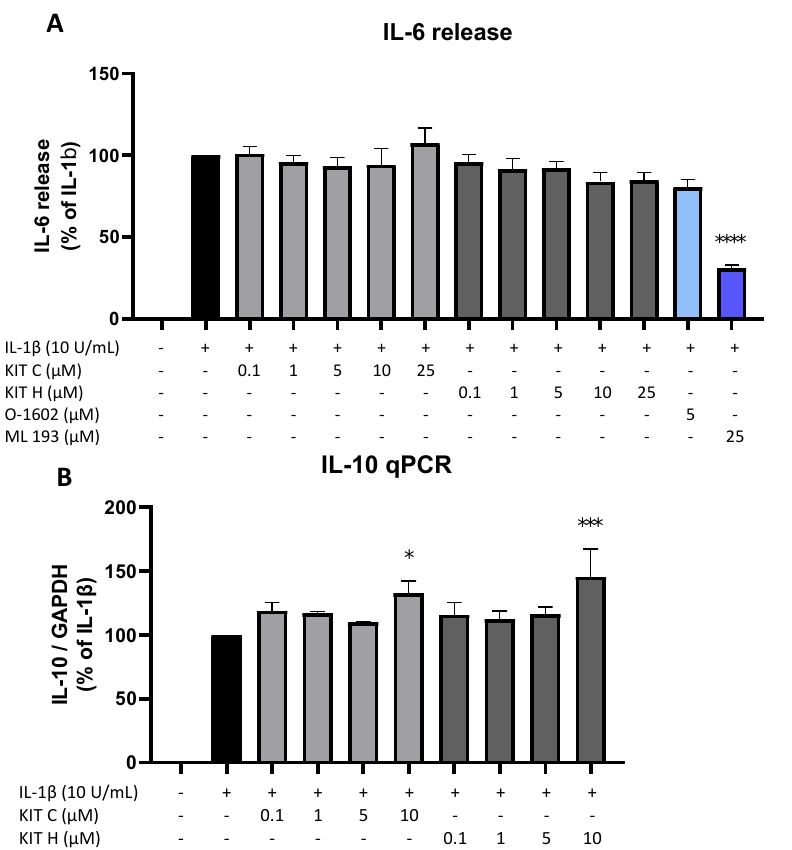
Figure 7. Effects of KIT C (light grey bars), KIT H (dark grey bars), O-1602 (light blue bar), and ML 193 (blue bar) on IL-6 release ( A ) and effects of KIT C and KIT H on IL-10 mRNA expression ( B ) in IL-1 β -stimulated SK-N-SH cells. Cells were stimulated as described under material and methods. After 24 h of stimulation, supernatants were collected and the release of IL-6 was measured by ELISA ( A ). After 4 h of stimulation, RNA was isolated and the mRNA levels of the shown target genes were measured using qPCR. Values are presented as the mean ± SEM of at least three independent experiments. Statistical analysis was performed using one-way ANOVA with Dunnett’s post hoc tests with * p < 0.05, *** p < 0.001 and **** p < 0.0001 compared to IL-1 β